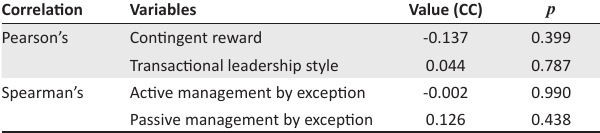
TABLE 4: Instrumental motivation and transactional leadership